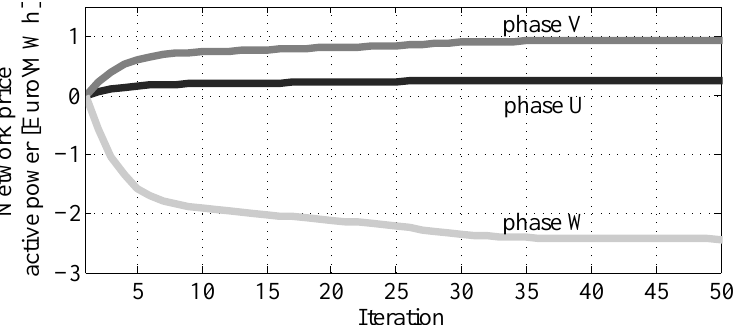
Figure 8. Convergence of the network price at Node